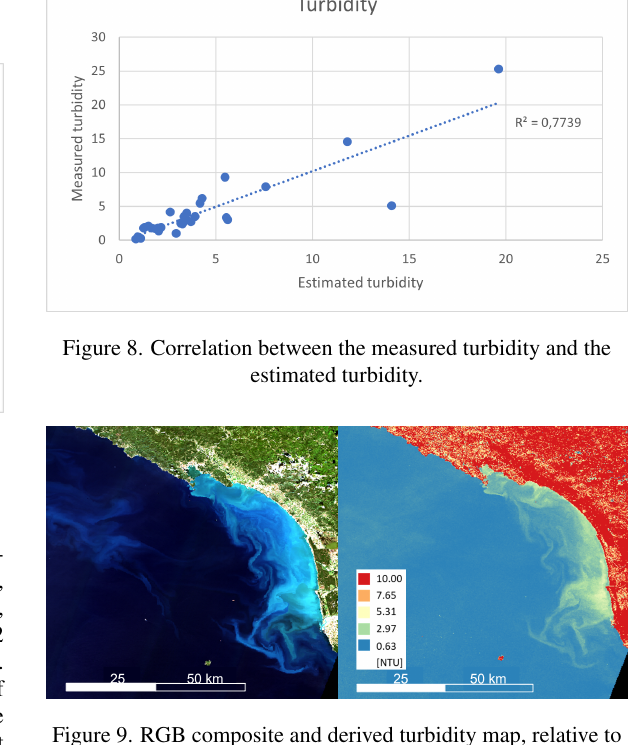
Figure 9. RGB composite and derived turbidity map, relative to 13 October